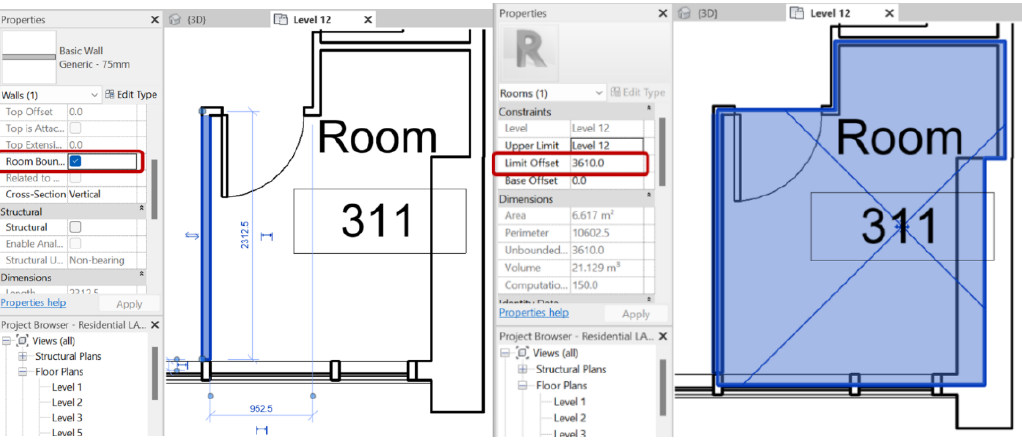
Figure 3. Room bounding setting for a wall (left) and limit offset setting for a room (right).